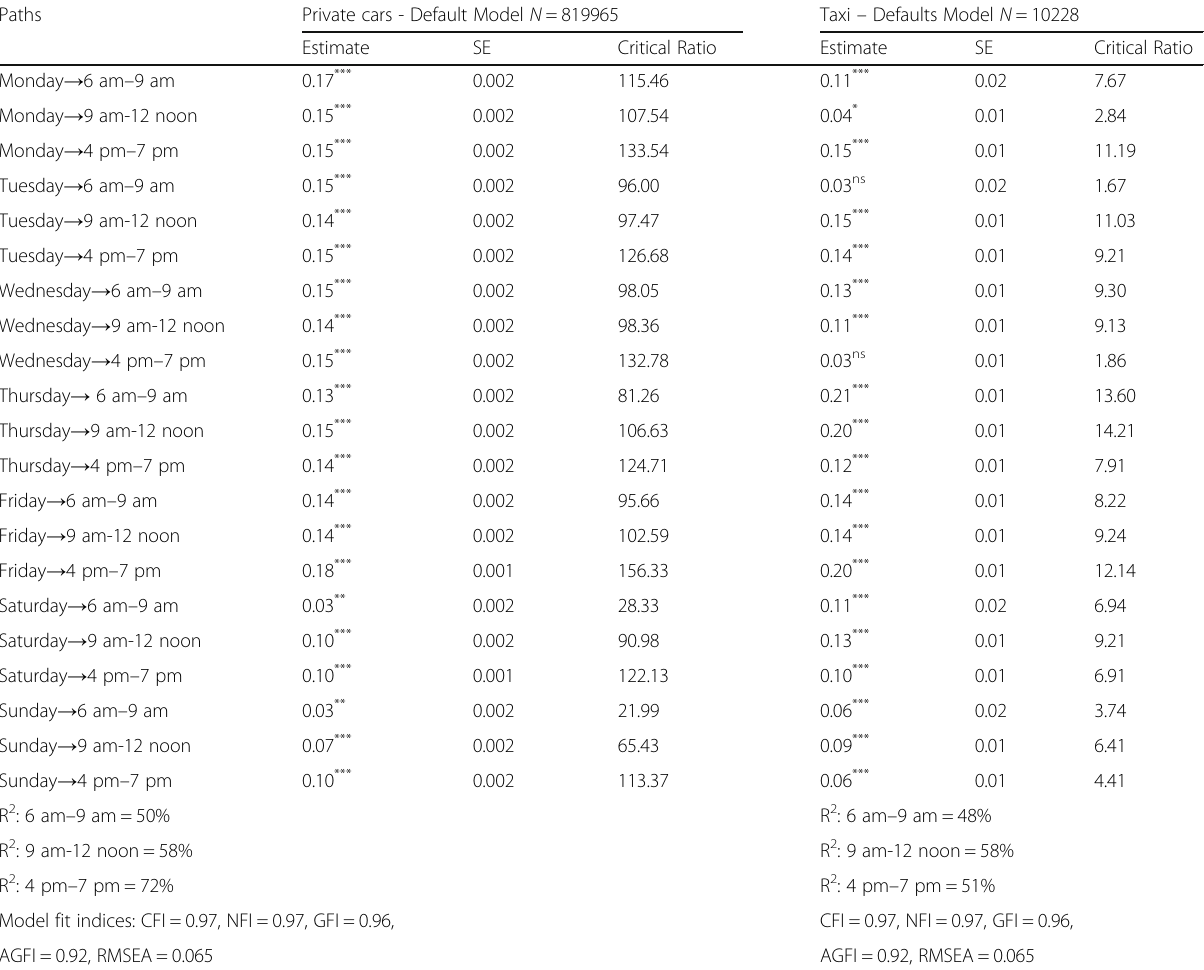
Table 8 Structural Model: Comparing the movement of private car and taxi predicting peak hours